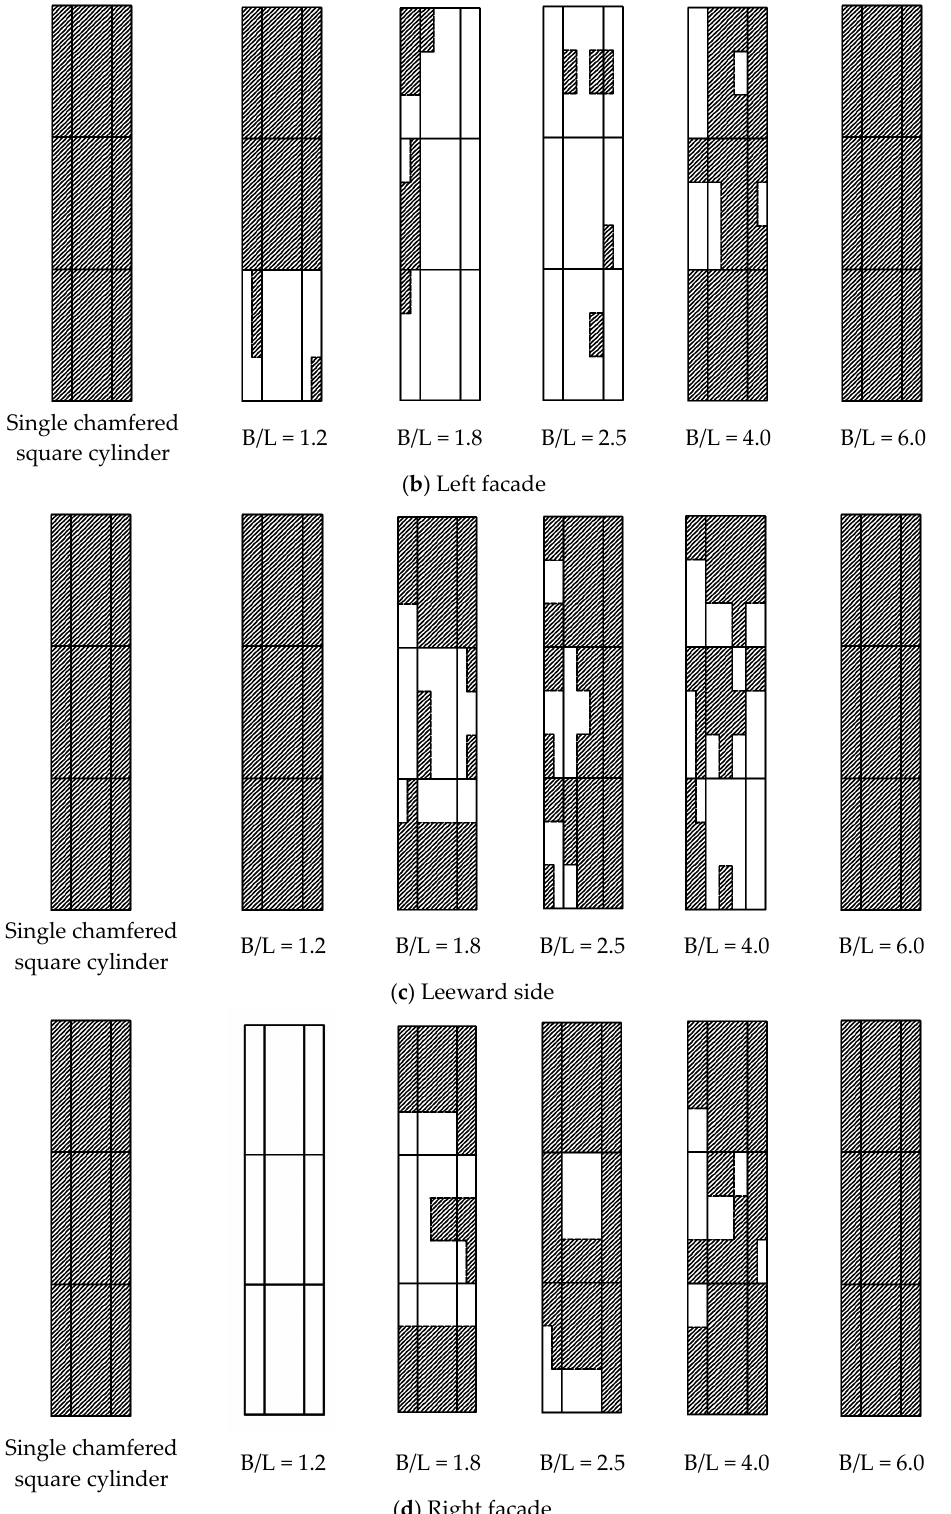
Figure 9. Non-Gaussian wind pressure distribution area of parallel square cylinders (filled region) .